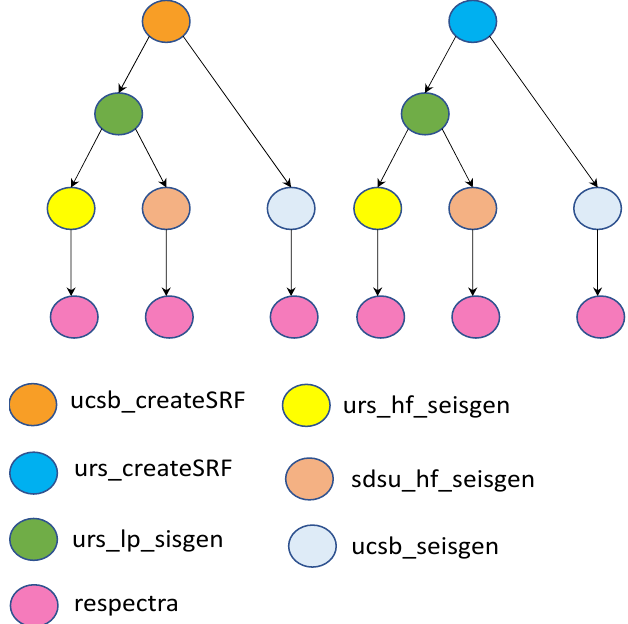
Figure 3. Broadband workflow .